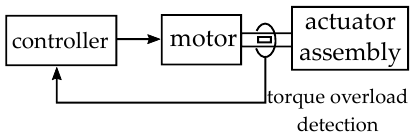
Figure 24. Block diagram of electronics based torque